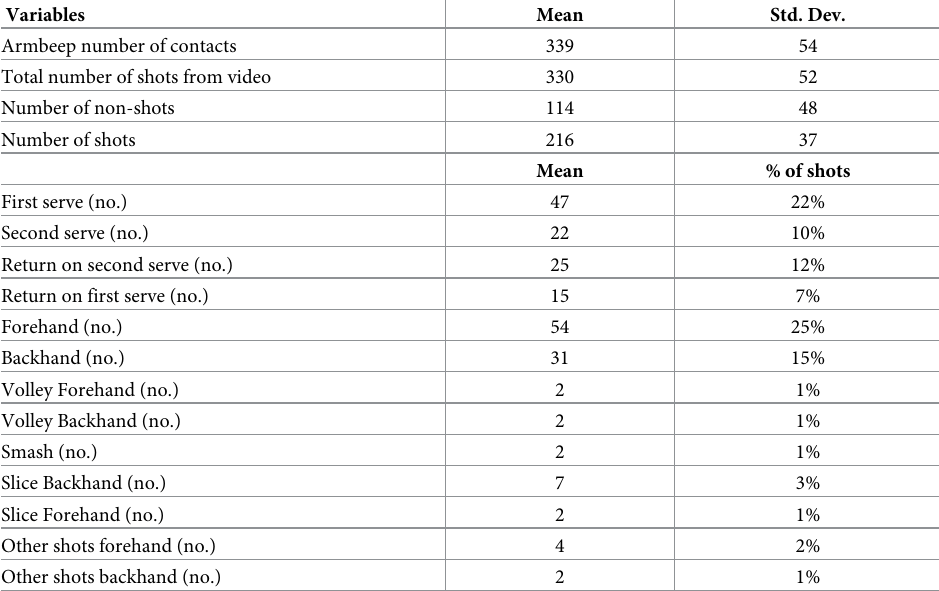
Table 4. Number of contacts from Armbeep sensor and number of shots collected with video analysis during matchplay. Variables